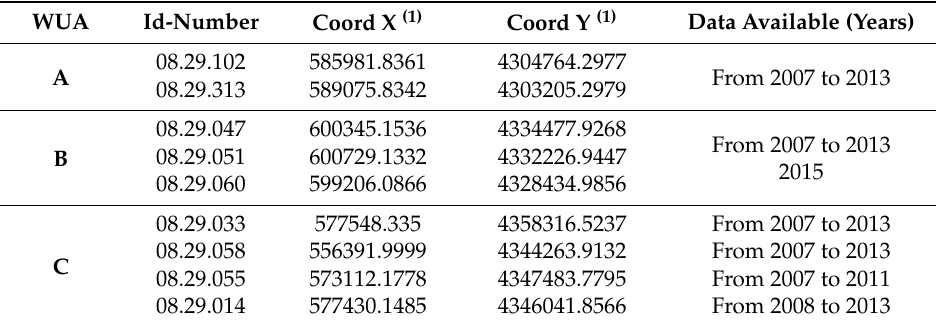
Table 3. Piezometer information for each irrigated area.